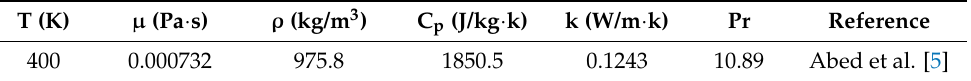
Table 3. Thermal properties of Therminol® VP-1 heat transfer fluid, used in the present study. T